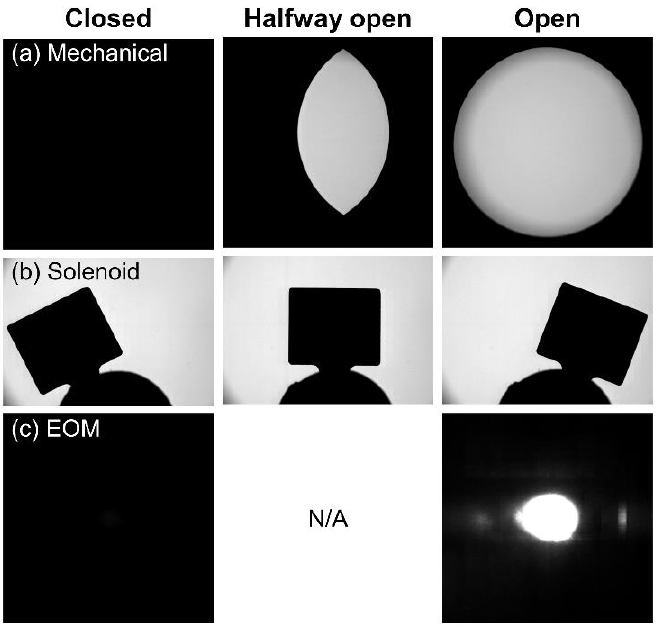
Figure 3. Frames of high-speed video footage used to measure the position of each shutter over time. ( a ) Mechanical shutter. ( b ) Solenoid Shutter. ( c ) EOM shutter.